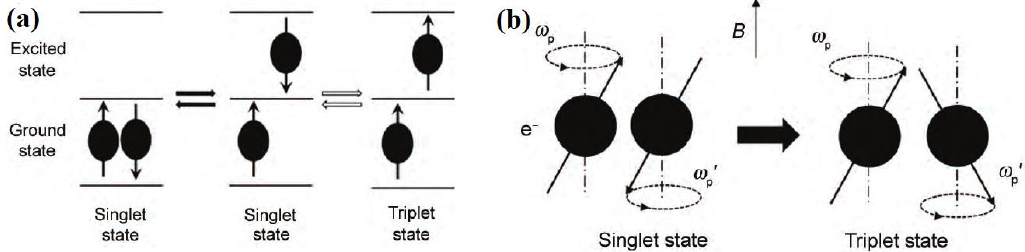
Figure 11. ( a ) Transforming relationship of the spin energy state of the electron pair and ( b ) transformation of the state of electron spin under pulsed magnetic field [30].